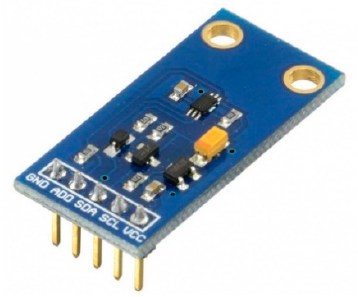
Figure 7. BH1750 FVI light sensor.